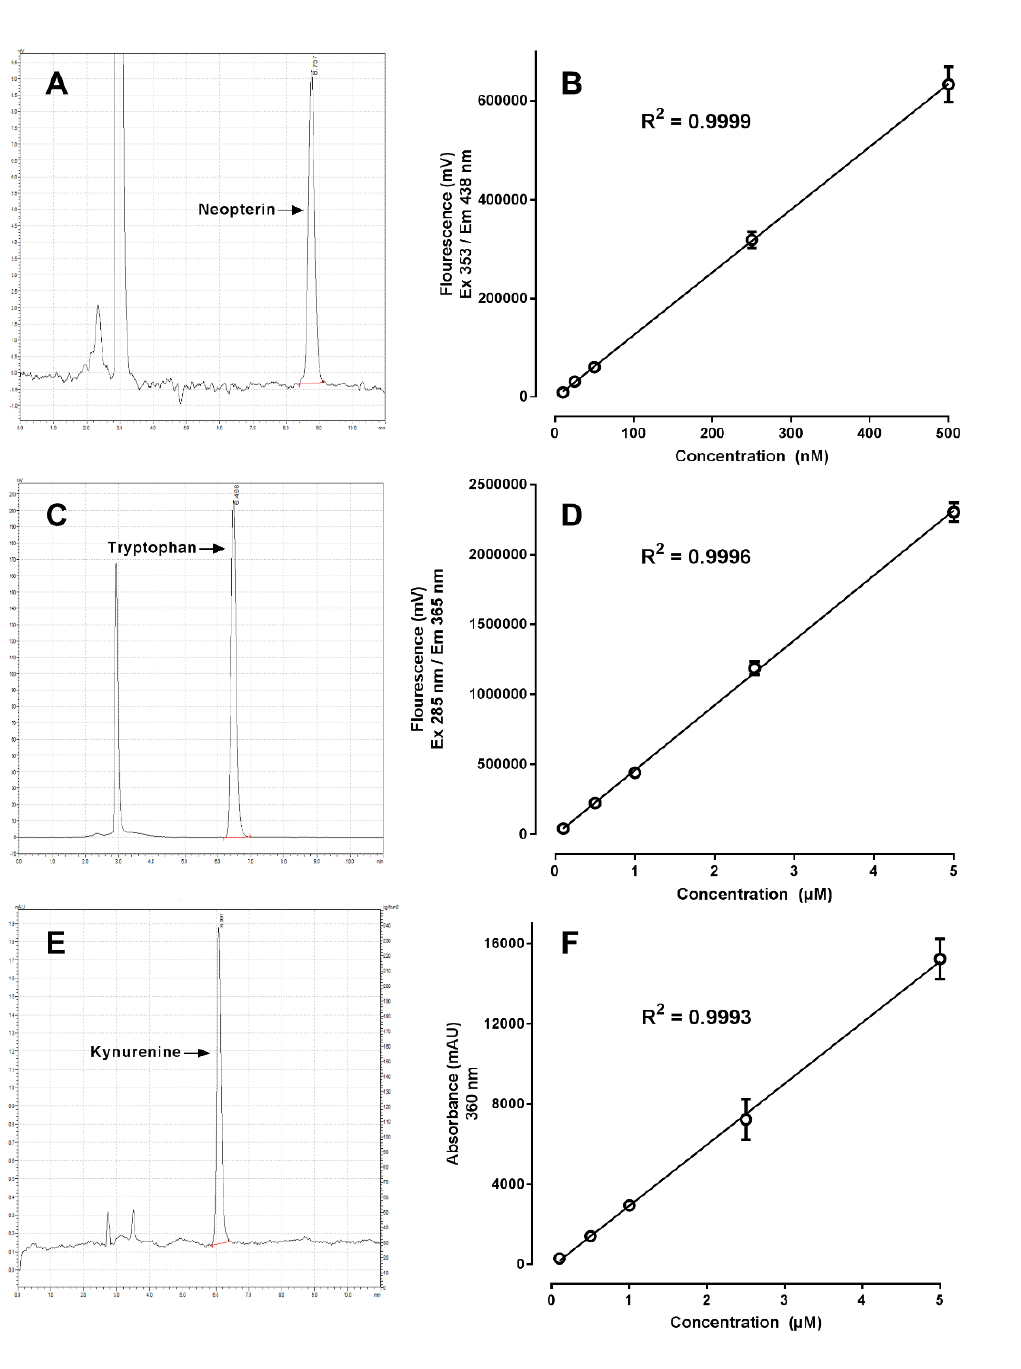
Figure 1: Chromatograms and standard curves of neopterin (A and B), tryptophan (C and D) and kynurenine (E and F). Retention times are 8.8 and 6.5 minutes for neopterin (100 nM) and tryptophan (5 µM), respectively and are measured by fluorescence. Kynurenine (5 µM) elutes at 6.1 minutes and is measured by absorbance (360 nm). All standard curves are in triplicate produced over 3 separate amine columns and demonstrate linear curves with high R 2 values. Standard curve data is presented as mean with